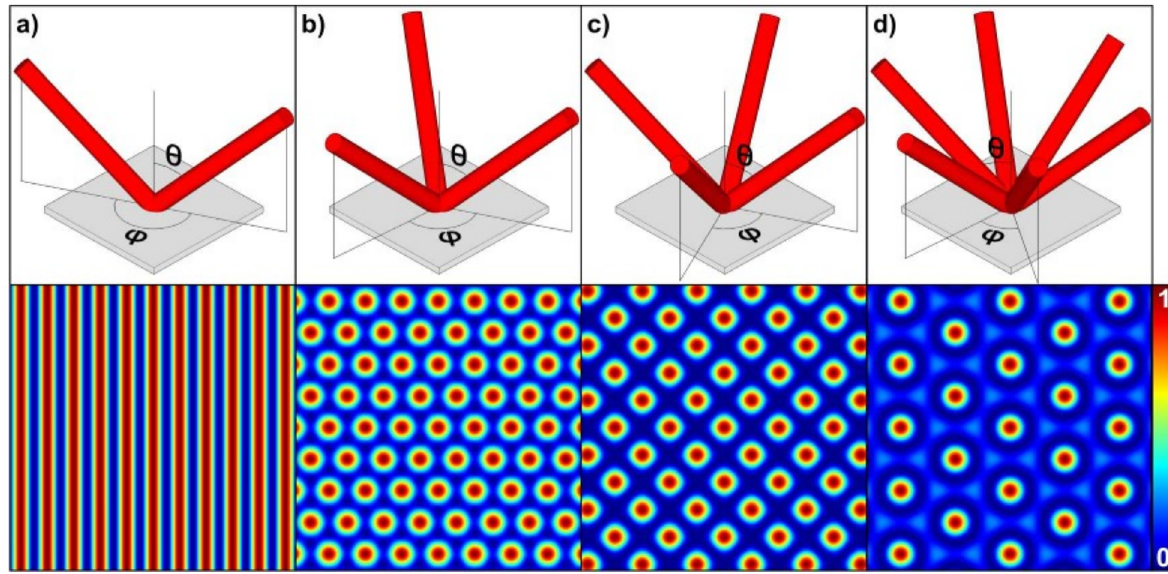
Figure 1: Schematic showing the set-up (upper row) and the resultant patterning (lower row) with (a) two, (b) three, (c) four and (d) six overlapping beams together with the calculated intensity of each interference pattern. Figures adapted from ref. [24] (© 2019, Springer International